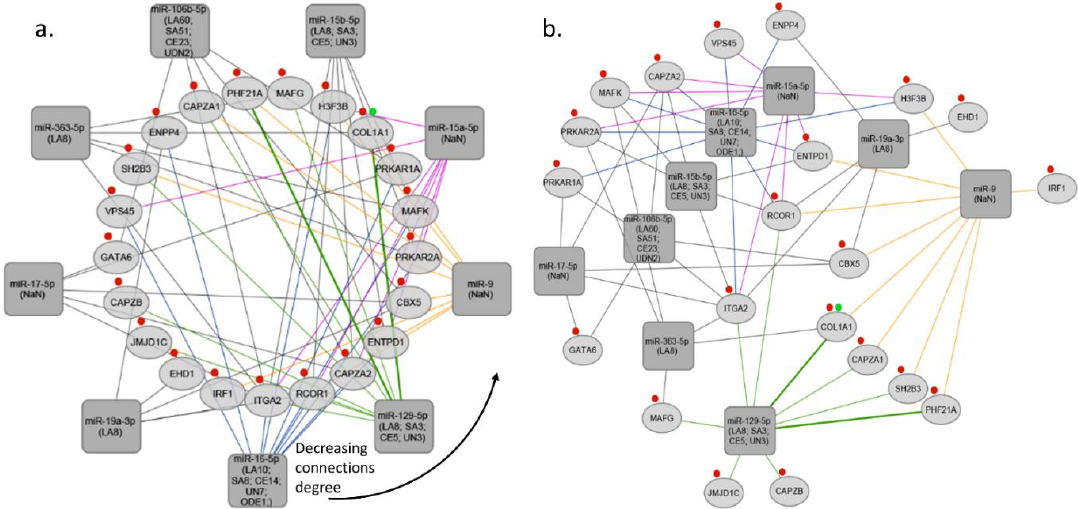
Figure 3. miRNA-target gene networks based on blood coagulation. ( a ) Blood coagulation- network sorted by the degree of connections, ( b ) Blood coagulation-interaction network. The rectangles indicate the stroke type miRNAs, the ellipses indicate target genes. Red and green marks represent specific GO process-blood coagulation and platelet activation, respectively. LA, large artery stroke; SA, small artery stroke; UDN, stroke due to undetermined cause; CE, cardioembolic stroke; NaN, no data; ODE, other determined etiology; UN, determined cause.